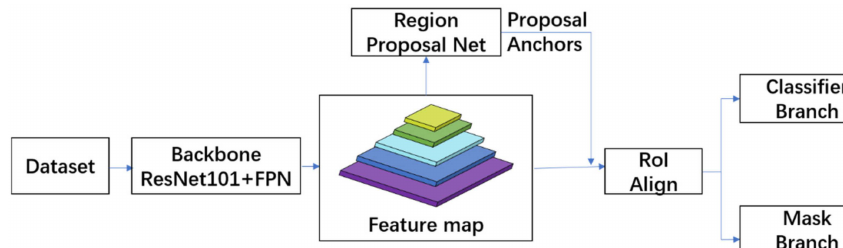
Figure 12. Sketch architecture of Mask R-CNN.